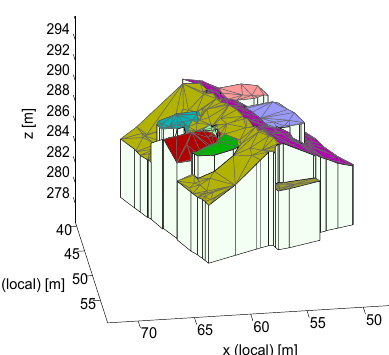
Figure 7. Reconstructed city scenes.